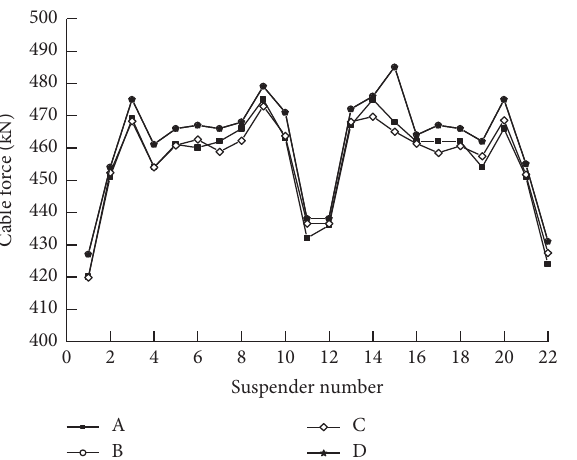
Figure 8: Completion cable force after adjustment. (A: cable force measured before upstream adjustment, B: upstream target value, C: measured cable force after downstream adjustment, D: downstream target